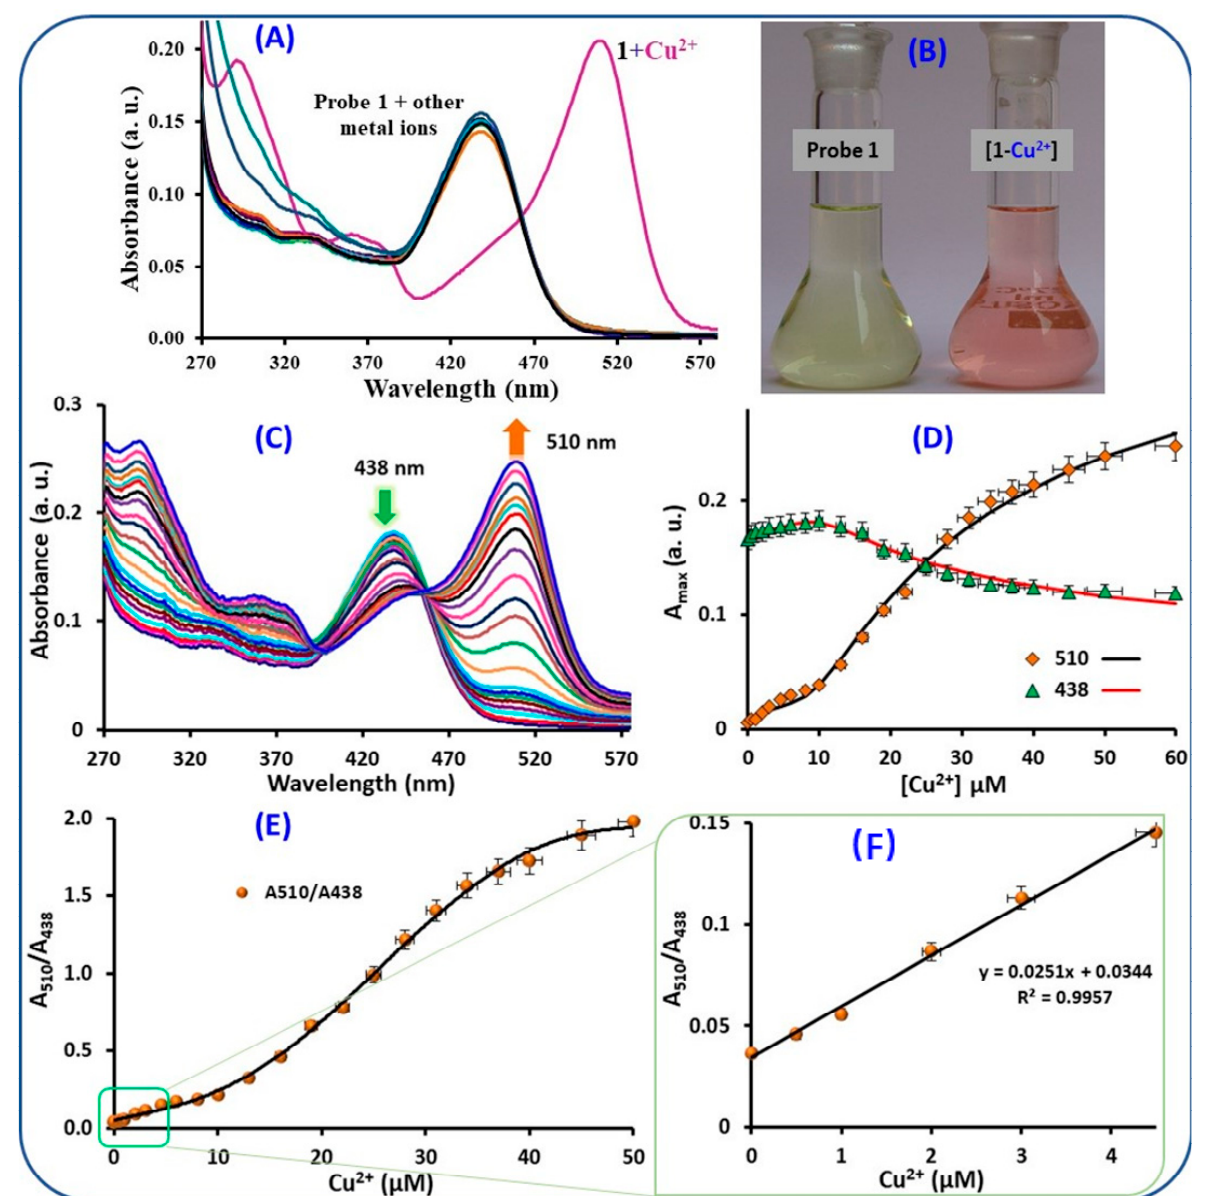
Figure 2. ( A ) UV-visible spectra of probe 1 (10 µ M, HEPES (pH 7.4): EtOH = 1:4) upon additions of various metal ions. ( B ) Color change of the probe solution in daylight upon addition of Cu 2+ . ( C ) UV-visible titration of probe 1 with Cu 2+ . ( D ) Fitting of titration data using absorption values at 438 and 510 nm ( A 438 and A 510 ). ( E ) Change in absorbance ratio ( A 510 / A 438 ) as a function of [Cu 2+ ]. ( F ) Expanded version of (E) focusing on a low [Cu 2+ ] range (0–4.5 µ M). Points and curves represent experimental values and curve fits, respectively.